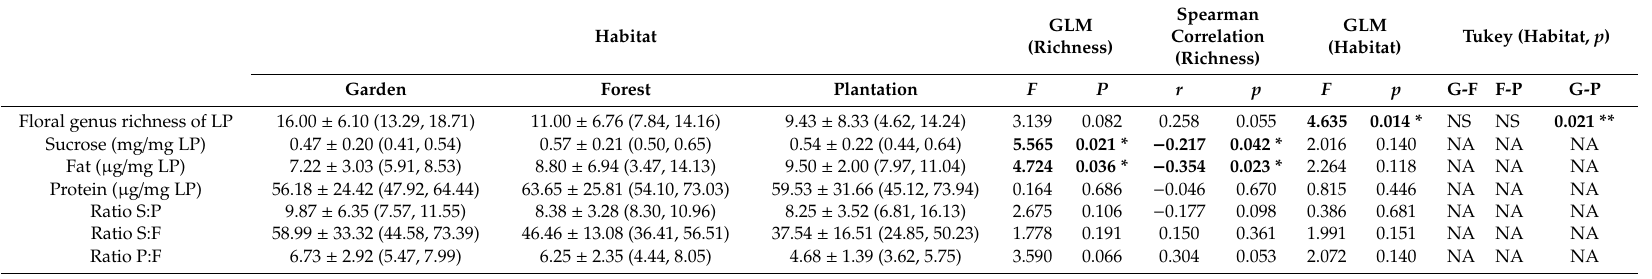
Table 1. Means ± standard deviation and lower and upper 95% confidence intervals (in brackets) of the number of floral sources (floral genus richness), the sucrose, total fatty acid (fat) and total amino acid (protein) content as well as ratios of sucrose-to-protein (S:P), sucrose-to-fat (S:F) and protein-to-fat (P:F) found in larval provisions (LP) of Tetragonula carbonaria colonies placed in three di ff erent habitats (gardens (G), forests (F) and plantations (P)). Results shown for generalized linear models (GLM, F - and p -values) on surrounding plant species richness (richness) and habitat e ff ects, Spearman correlations against surrounding plant species richness (correlation coe ffi cients r and p -values p ) and Tukey-posthoc-comparisons for habitat (Tukey). Bold values indicate significant di ff erences and / or correlations and asterisks give significance levels (* p < 0.05, ** p < 0.01). NS—not significant ( p > 0.05). NA—not applicable /